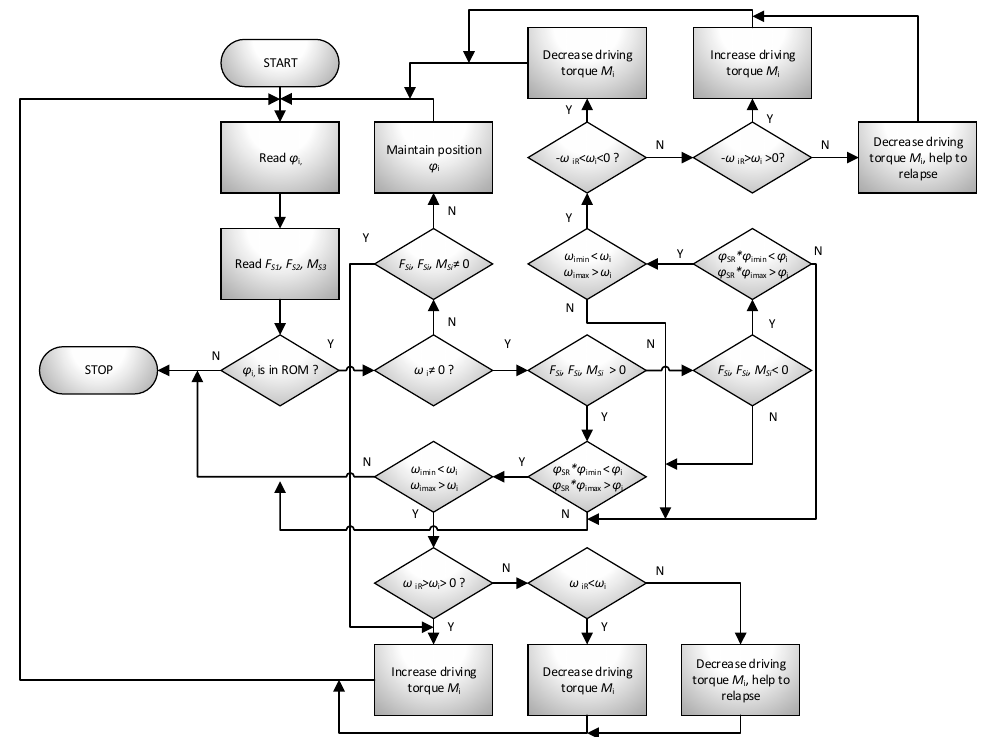
Figure 10. Algorithm of the MWR operation during intentions prediction method.